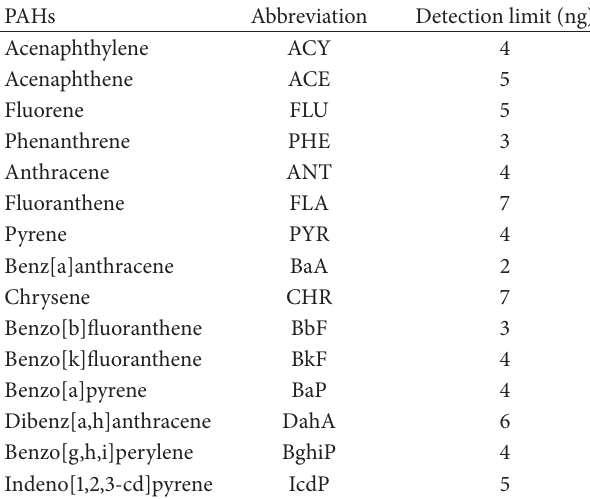
Table 2: Statistical description of PAH concentrations in particulate samples at Mount